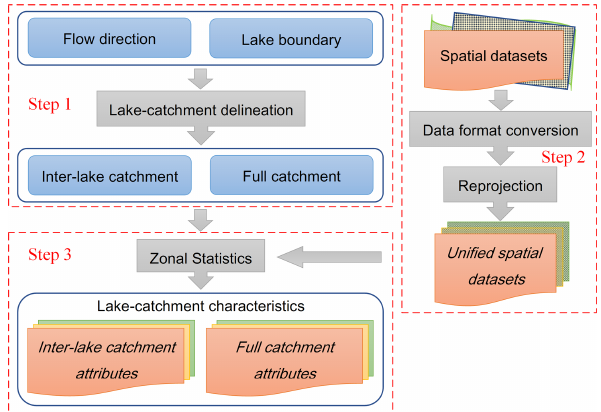
Figure 2. Procedures to construct the dataset of lake-catchment characteristics for the TP